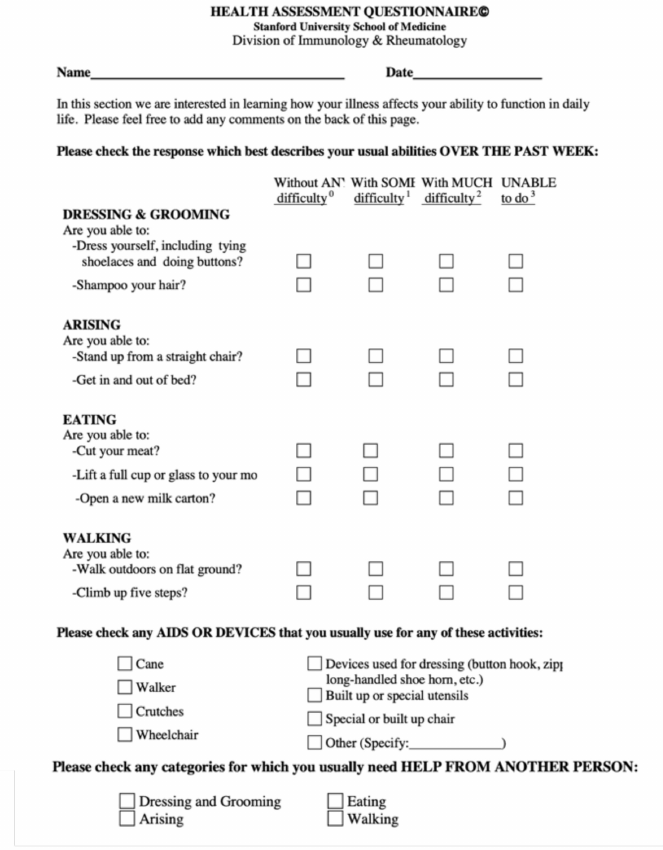
Figure 1. Health assessment questionnaire reproduced from Ramey DR, Fries JF, Singh G. in B. Spilker Quality of Life and Pharmacoleconomics in Clinical Trials, 2nd ed., The Health Assessment Questionnaire 1995—Status and Review. Philadelphia: Lippincott-Raven Pub., 1996, pp. 227–237